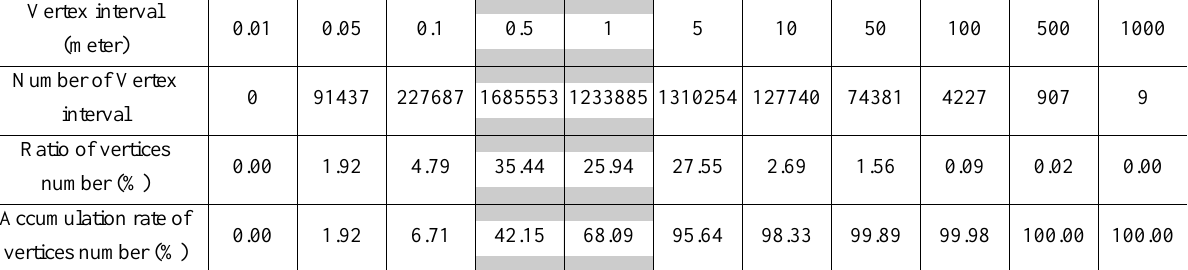
Table 1. The number of vertex according to different vertex interval (Jeollanam-do)